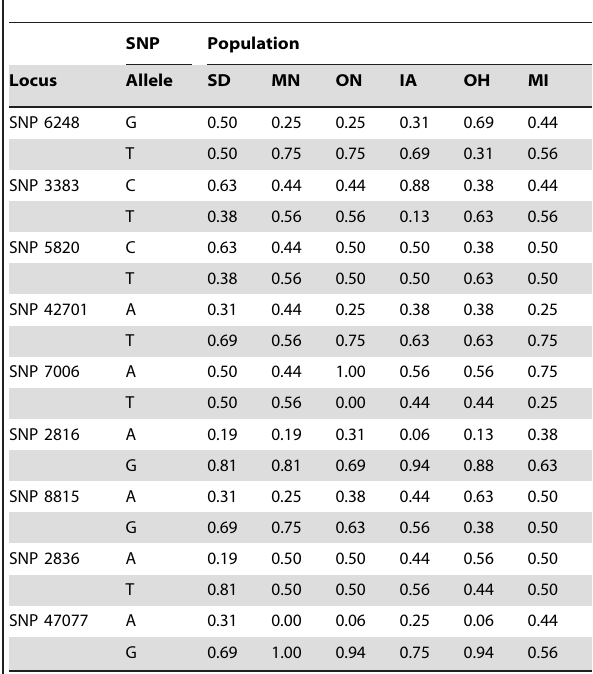
Table 2. SNP allele